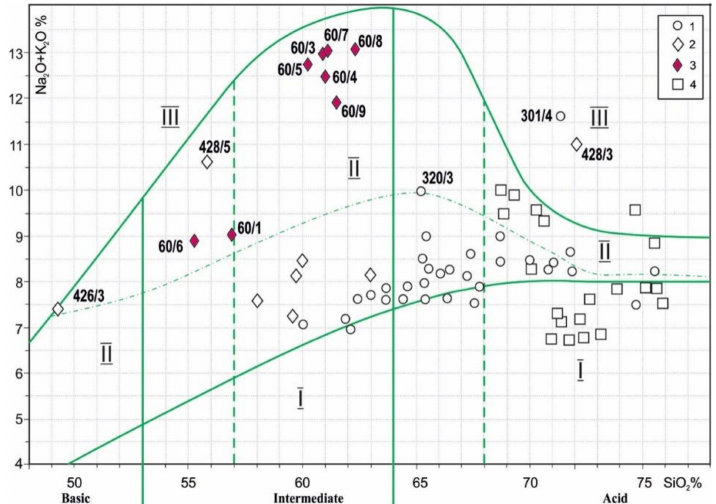
Figure 8. SiO 2 and Na 2 O + K 2 O ratios in the rocks of the Billyakh pluton and the dikes on a simplified classification diagram. Vertical lines divide the basic, intermediate, and acidic rocks, and their subdivisions are shown by dashed lines. The curved lines divide the rocks into fields by alkalinity, where I is normal, II is moderately alkaline, and III is alkaline, and the dashed line shows subdivisions in the moderately alkaline rocks. The figurative points of analyses were recalculated to 100%, without